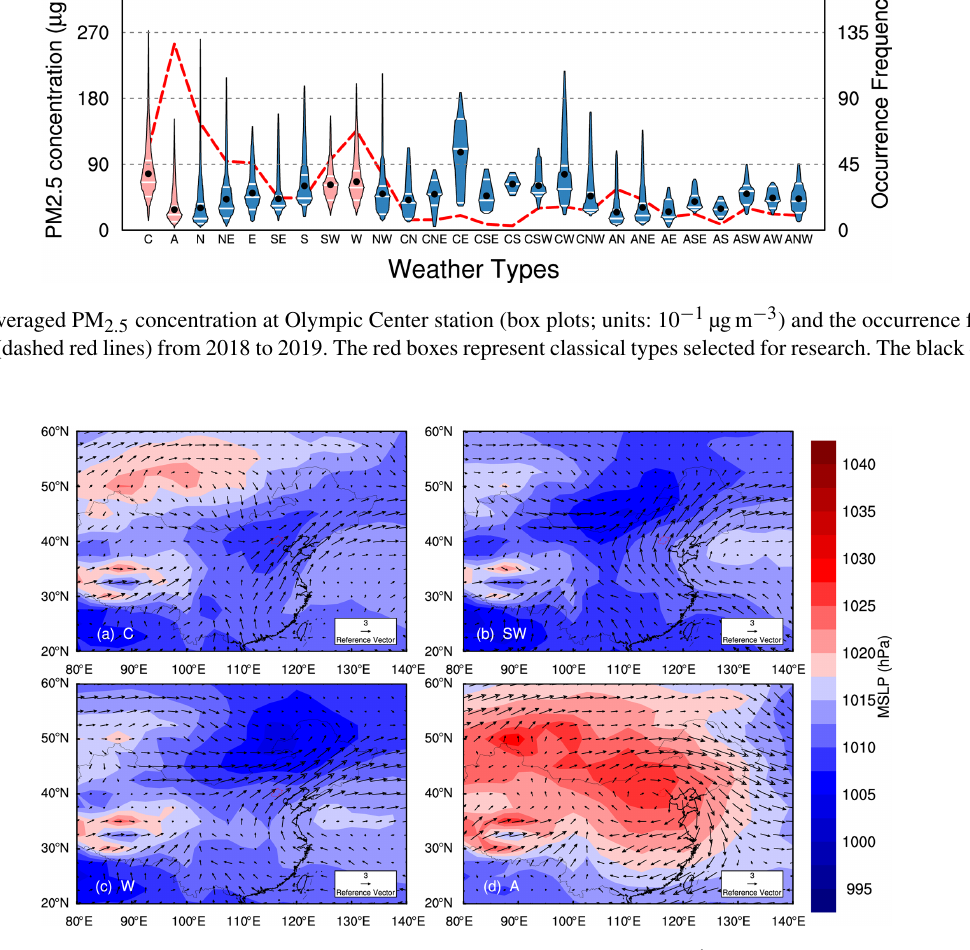
Figure 3. The daily MSLP (shaded; units: hPa) and wind fields at 925hPa (vectors; units: ms − 1 ) for types C (a) , SW (b) , W (c) , and A (d) from 2018 to